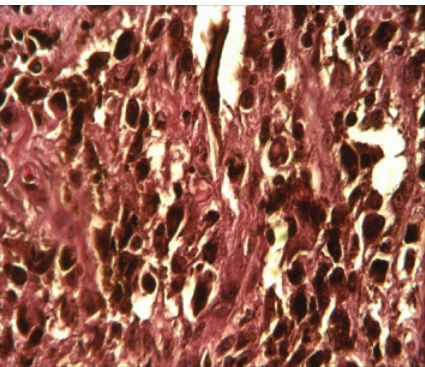
Figure 3: Histopathological aspect of pigmented melanoma, stage V of Clark and Mihm